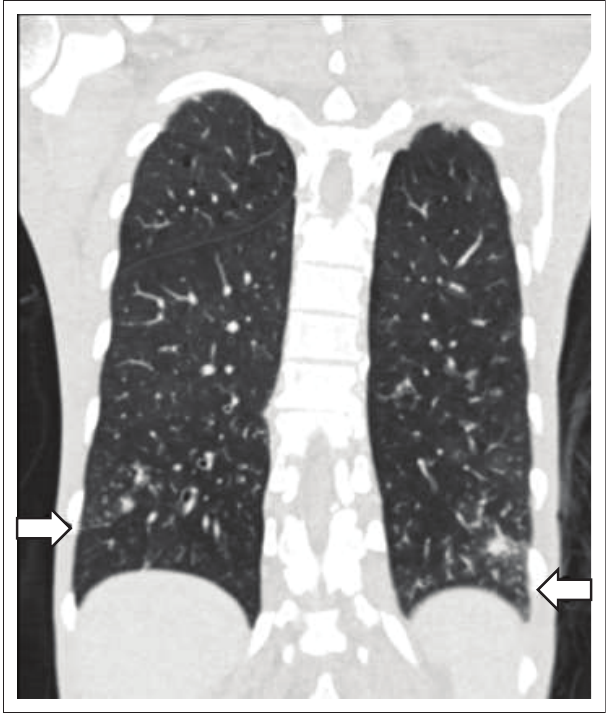
FIGURE 1: Coronal computerised tomography of the chest demonstrating bibasal lower lobe tree in bud appearance suspicious for TB.